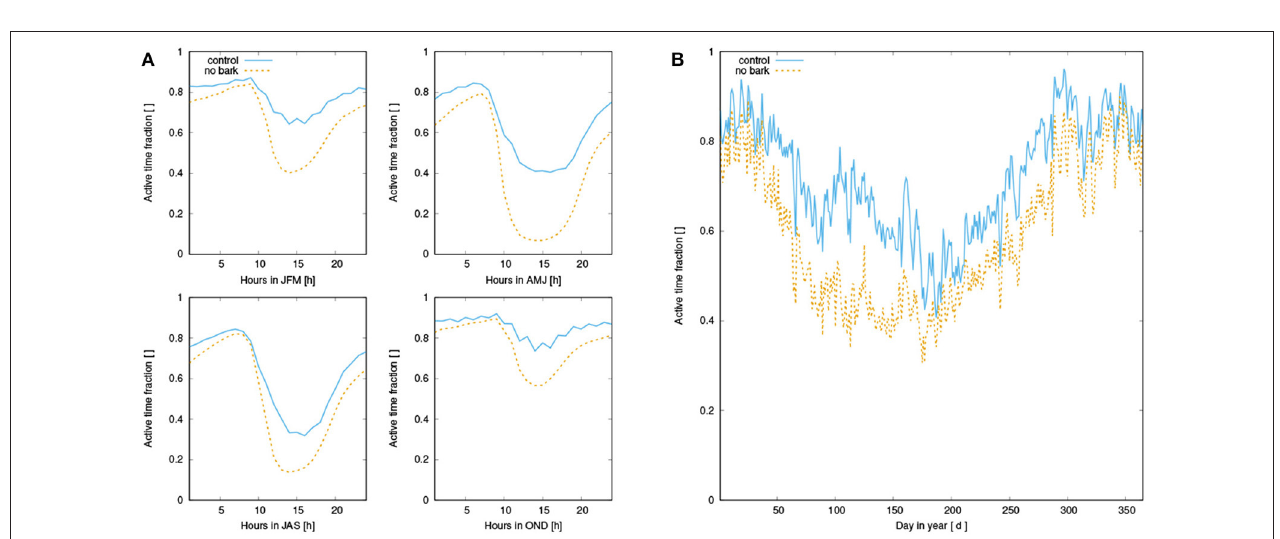
FIGURE A2 | (A) Mean diurnal activity pattern of simulated NV epiphytes for four seasons, averaged over all surviving strategies of the control run (blue, solid) and the run without bark reservoir (orange, dashed); (B) Seasonal pattern of activity.